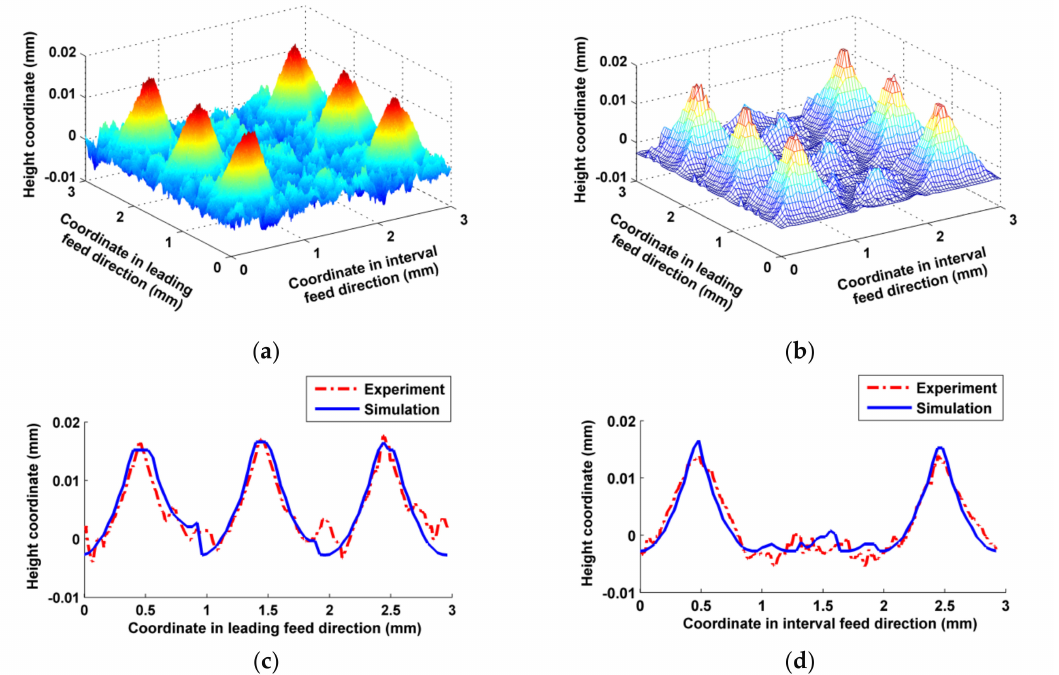
Figure 11. Comparisons between the simulated and experimental micro surface topography in vertical milling. ( a ) Actual milled surface topography; ( b ) Simulated surface topography; ( c ) Comparison of the sectional profiles in leading feed direction; ( d ) Comparison of the sectional profiles in interval feed